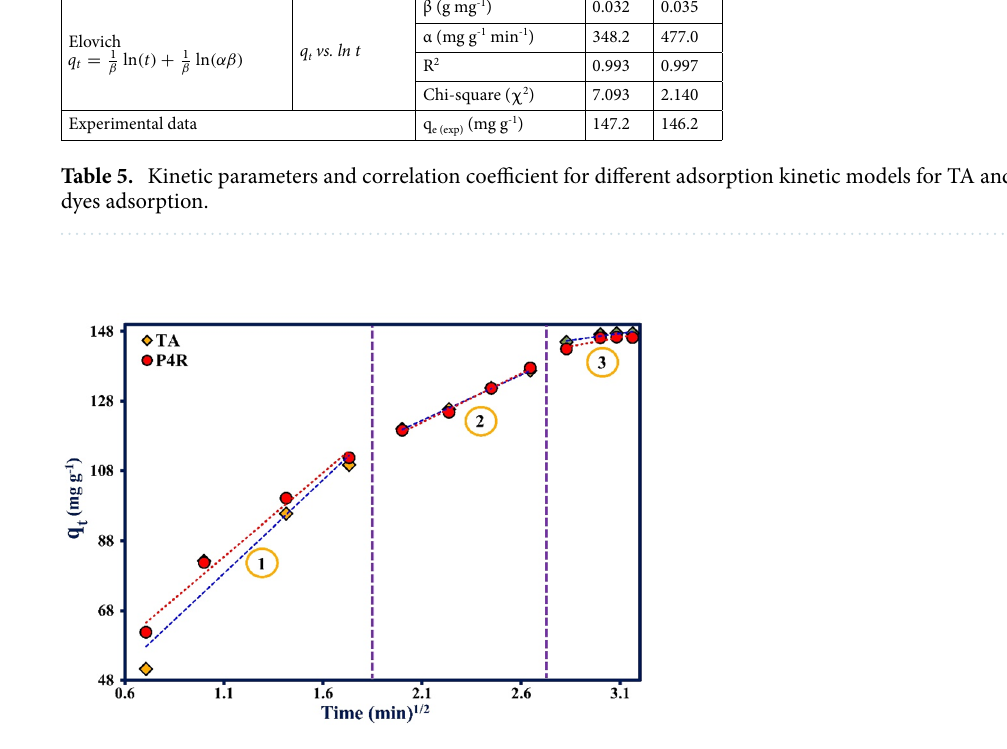
Figure 10. Weber-Morris intraparticle diffusion plot for the adsorptive removal of TA and P4R food dyes by